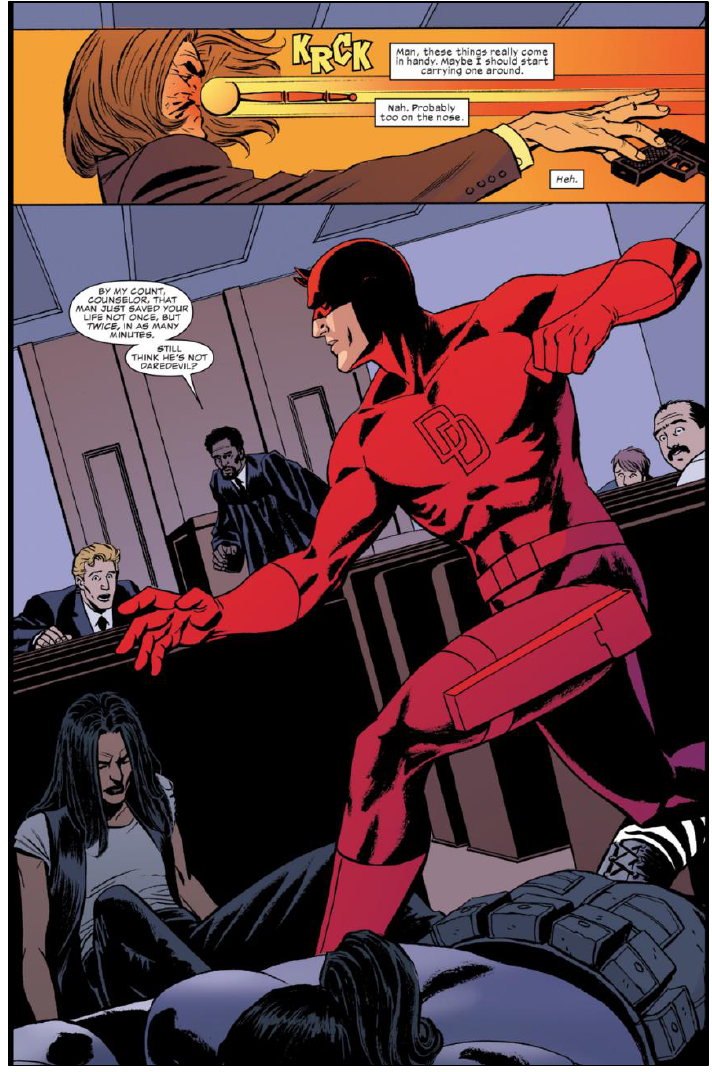
Figure 10. Page from Soule’s Daredevil: Back in Black Vol. 5: Supreme #22, 2017. Image Credit: Goran Sudžuka © 2017 Marvel Characters,